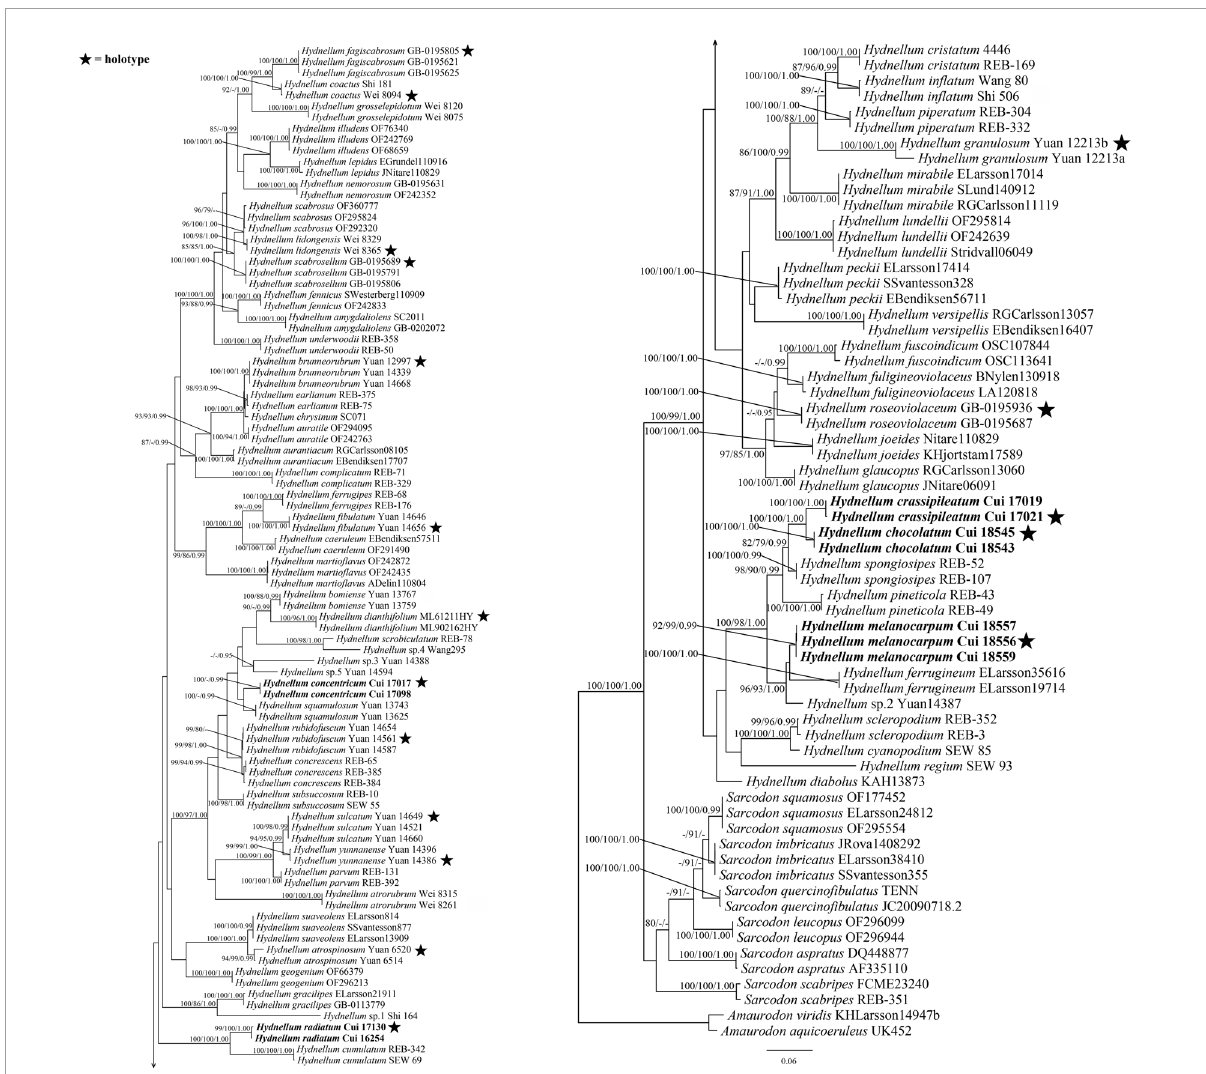
FIGURE1 Maximum likelihood (ML) tree of the Hydnellum species based on ITS + nLSU sequences data. Branches are labeled with parsimony bootstrap values equal to or higher than 75%, maximum likelihood bootstrap values equal to or higher than 75%, and Bayesian posterior probabilities equal to or higher than 0.95. Bold names = New